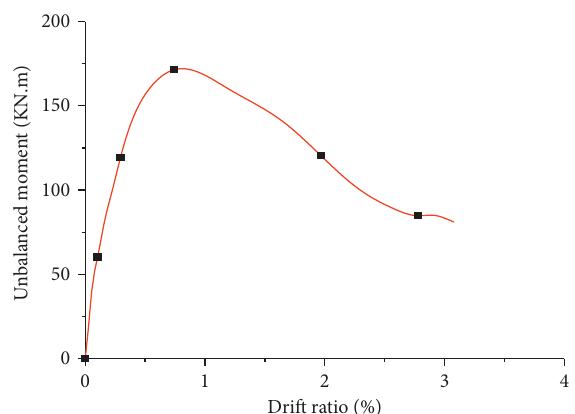
Figure 32: Control specimen’s unbalanced moment drift ratio response with 2400sec fre exposure.